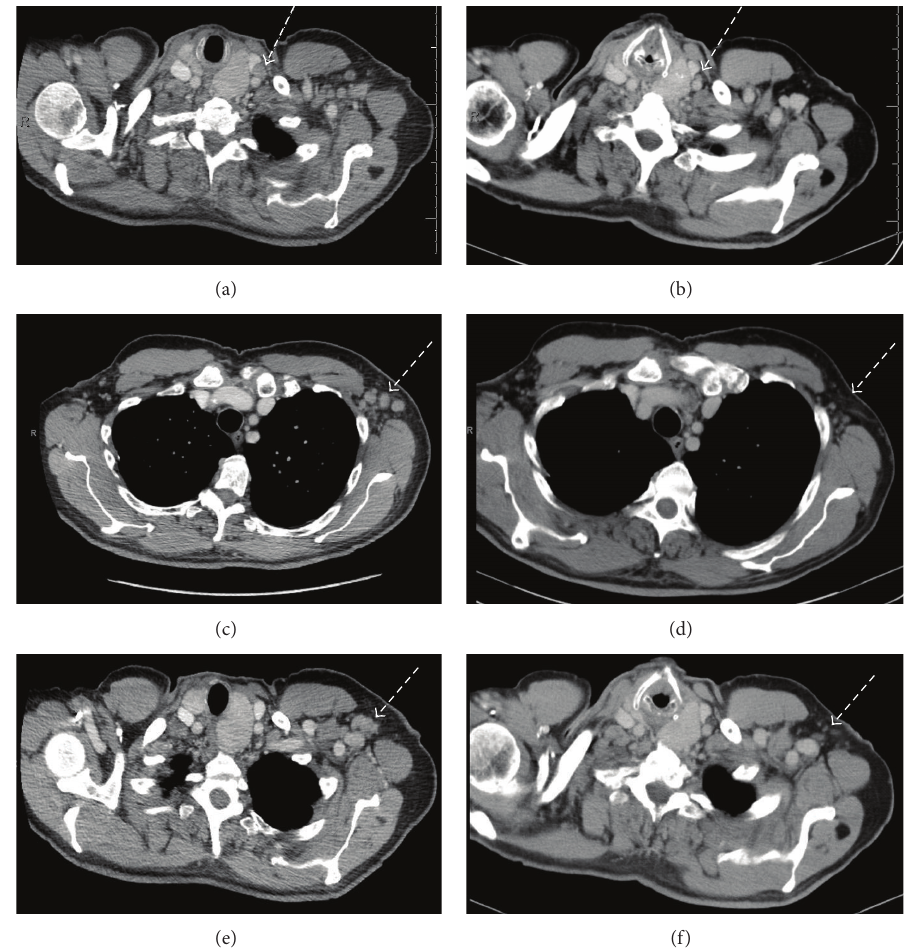
Figure3:(a)Pretherapyenlargedleftsupraclavicularlymphnode,(b)posttherapynormalizedleftsupraclavicularlymphnode,(c)pretherapy enlarged left axillary lymph nodes, (d) posttherapy normalized left axillary lymph nodes, (e) pretherapy enlarged left axillary lymph node, and (f) posttherapy normalized left axillary lymph